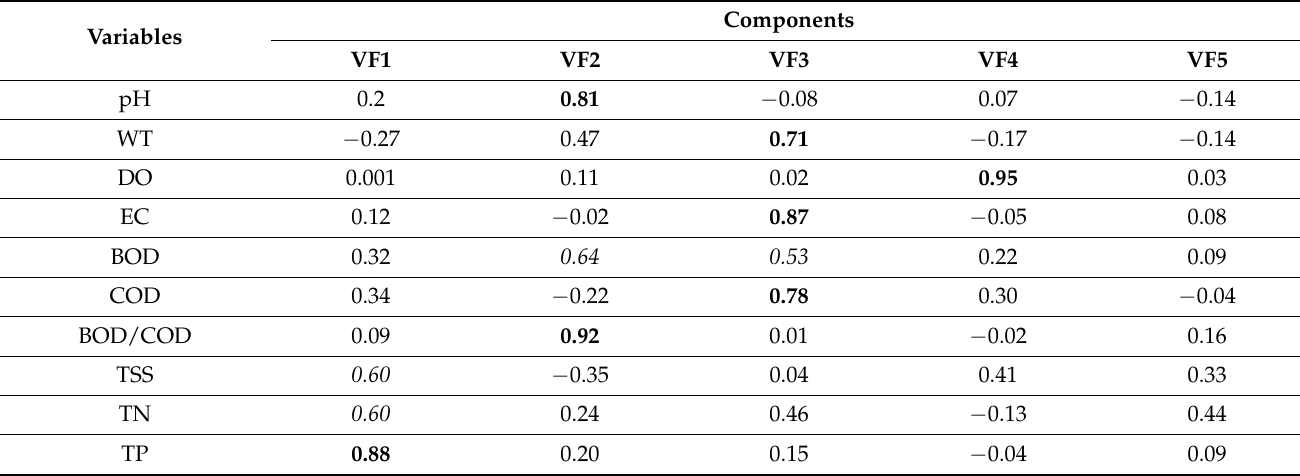
Table 4. Varimax rotated component matrix for water quality parameters (Kaiser–Meyer–Olkin (KMO) = 0.59, Bartlett’s test was significant ( p = 0.000), extraction method: principal component analysis, and rotation method: varimax with Kaiser normalization, and bold and italic values represent strong and moderate loadings, respectively). pH—hydrogen ion concentration, WT—water temperature, DO—dissolved oxygen, EC—electrical conductivity, BOD-biological oxygen demand, COD—chemical oxygen demand, TSS—total suspended solids, TN—total nitrogen, TP-total phosphorus,